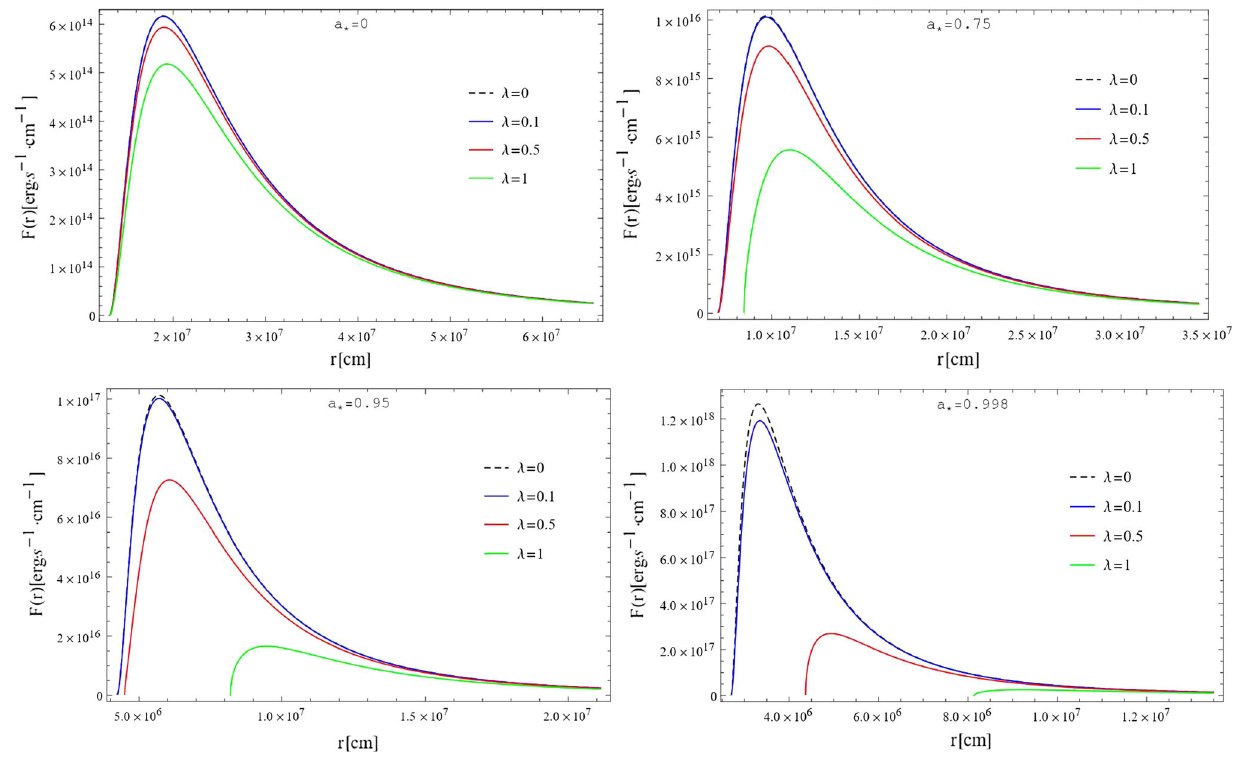
Fig. 2 The time averaged flux F ( r ) as a function of the radial coordinate r (in cm) radiated by the disk for a RDSWH plotted for different values of λ and compared with the Kerr